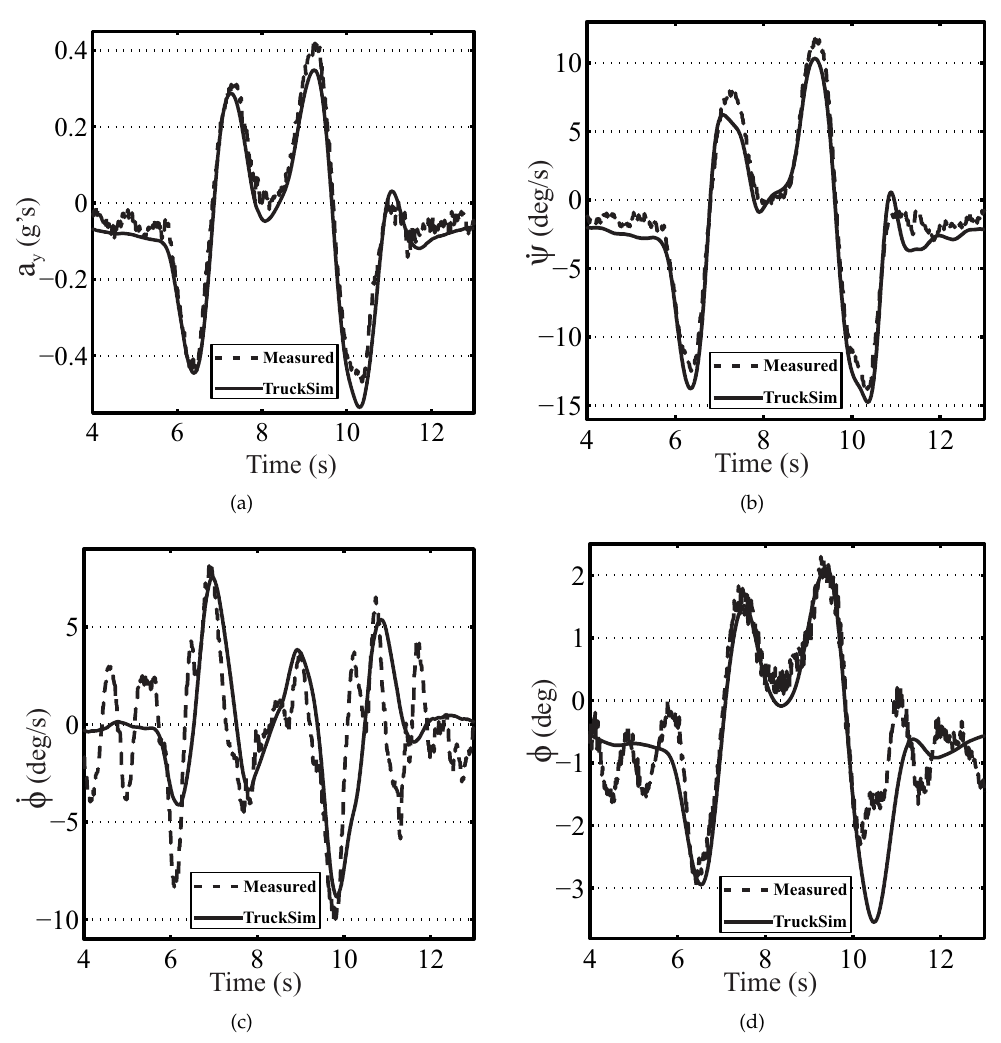
Figure 6. DLC maneuvers at 70 km/h for the experimental adjustment of vehicle model parameters (solid line: TruckSim; dashed line: measured): ( a ) lateral acceleration, ( b ) yaw rate, ( c ) roll rate and ( d ) roll angle.